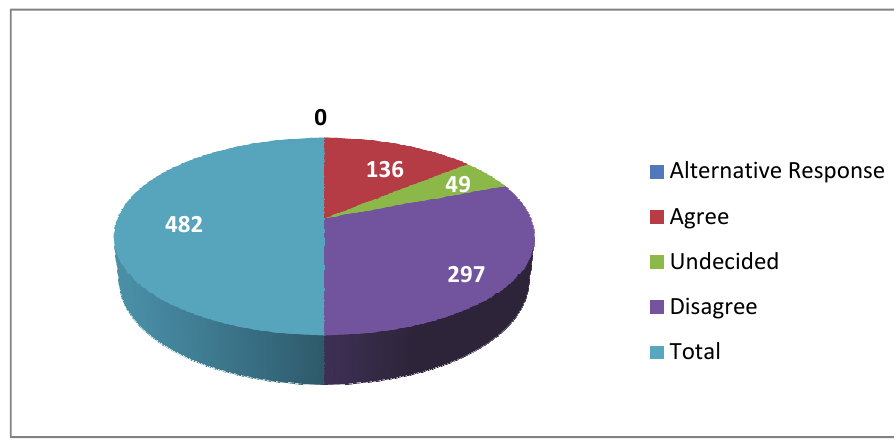
Source: Field Survey July,